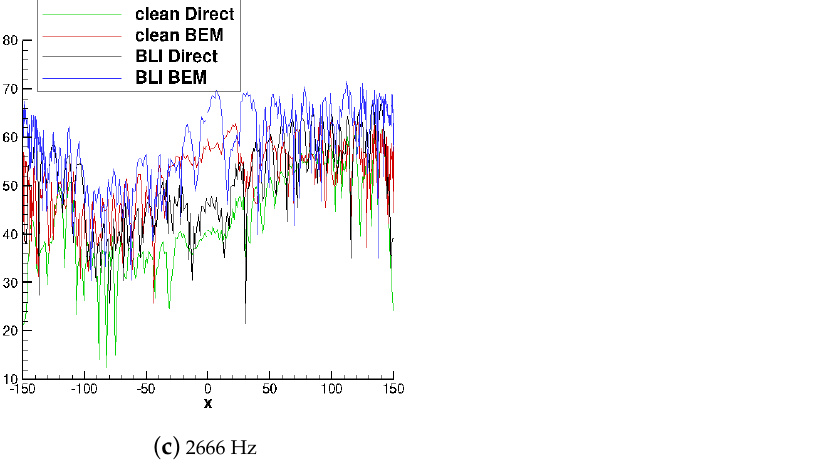
Figure 17. Comparison of scattered (BEM) results for three frequencies, along X axis.